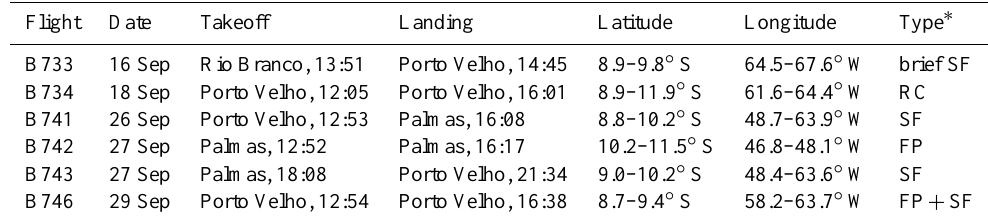
Table 1. Research flights considered in this article. Time is UTC. Flight Date Takeoff Landing Latitude Longitude